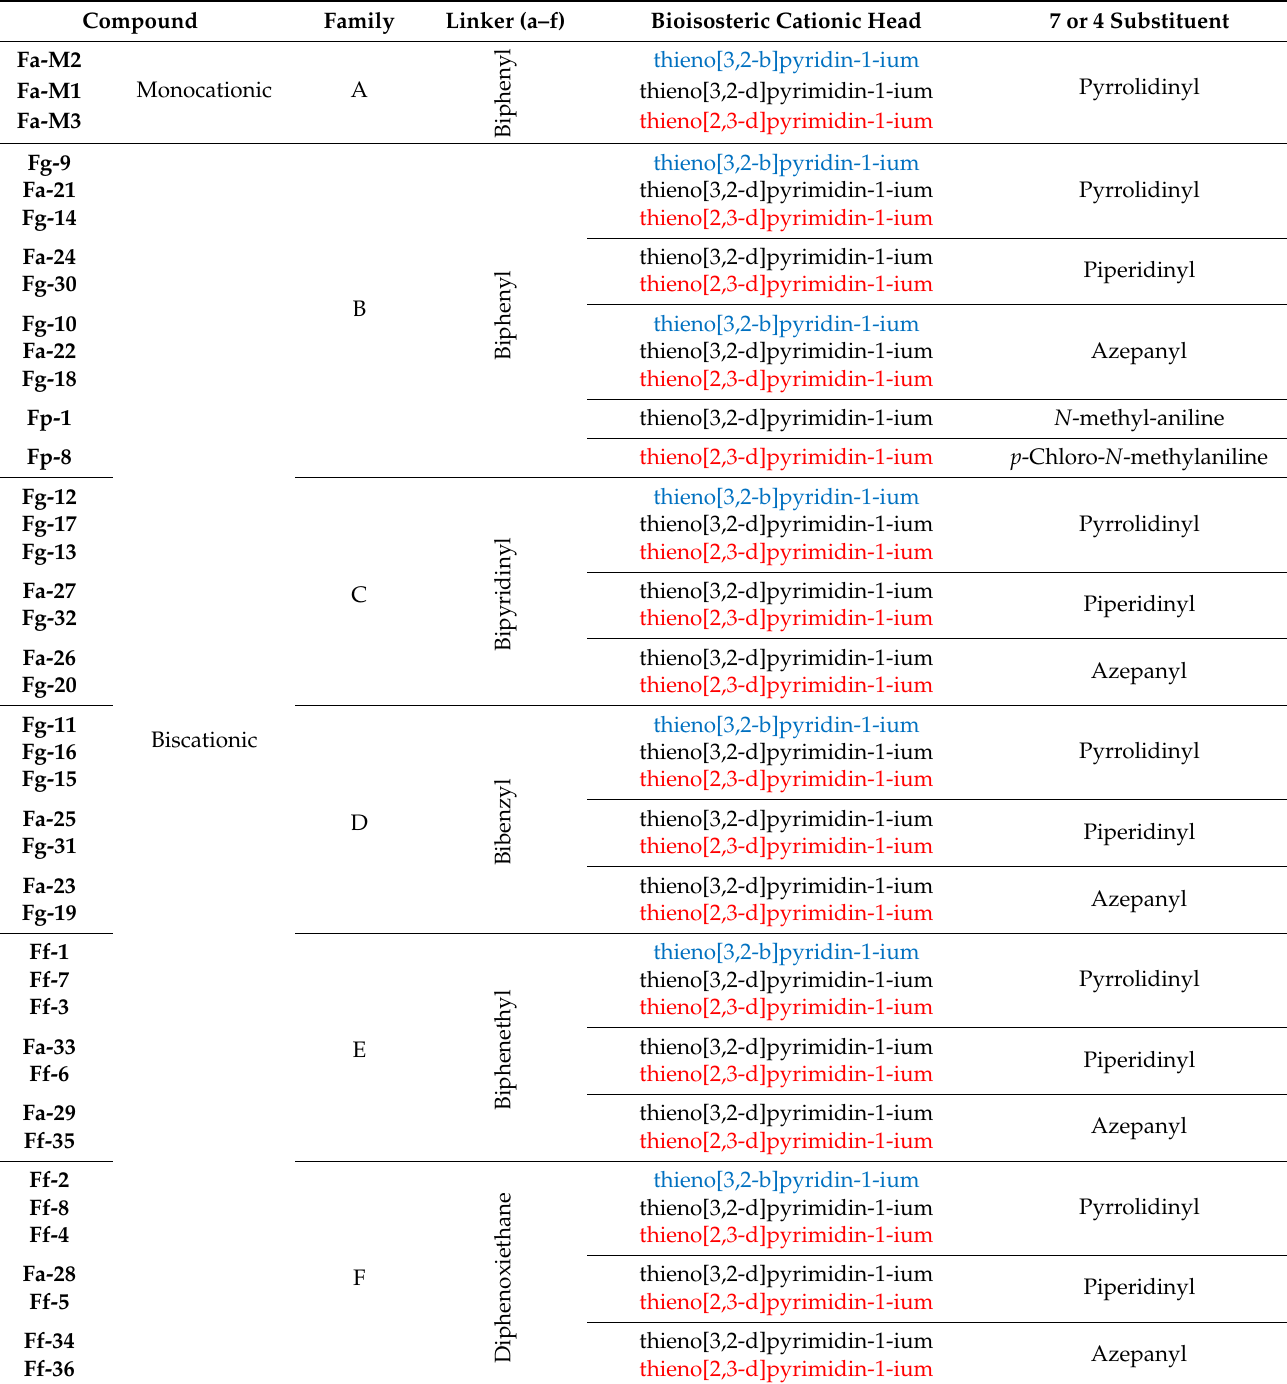
Table 1. Compounds synthetized and evaluated. The different bioisosteric cationic heads are shown in blue, black, and